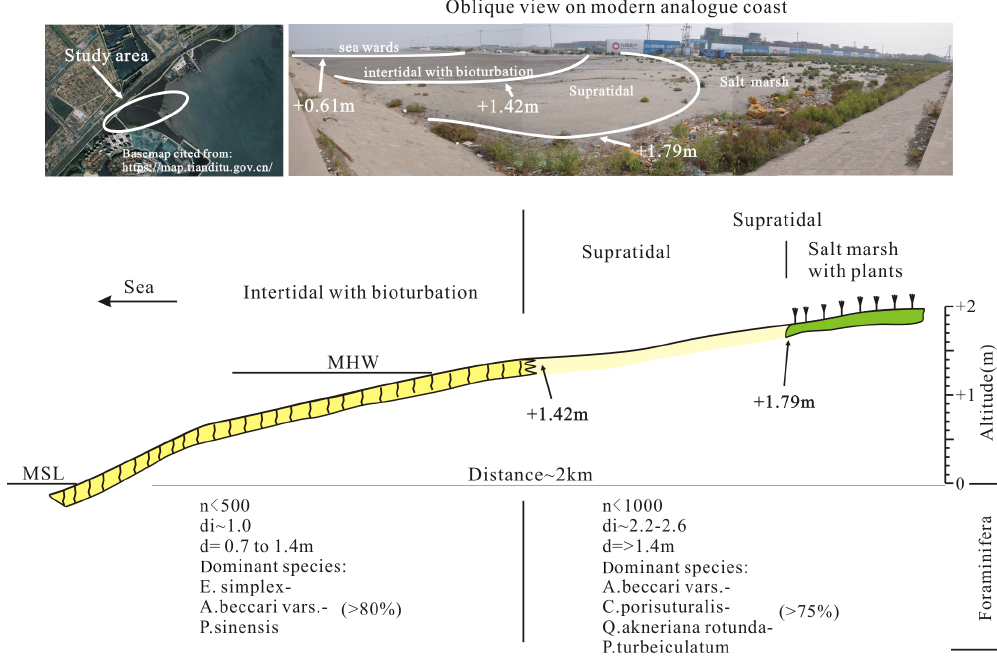
Figure 2. Schematic cross section of the modern tidal flat of the study area showing two characteristic foraminiferal zones. The base map of study area is derived from “map world” (https://www.tianditu.gov.cn/, last access: June 2020, National Platform for Common GeoSpatial Information Services, China).